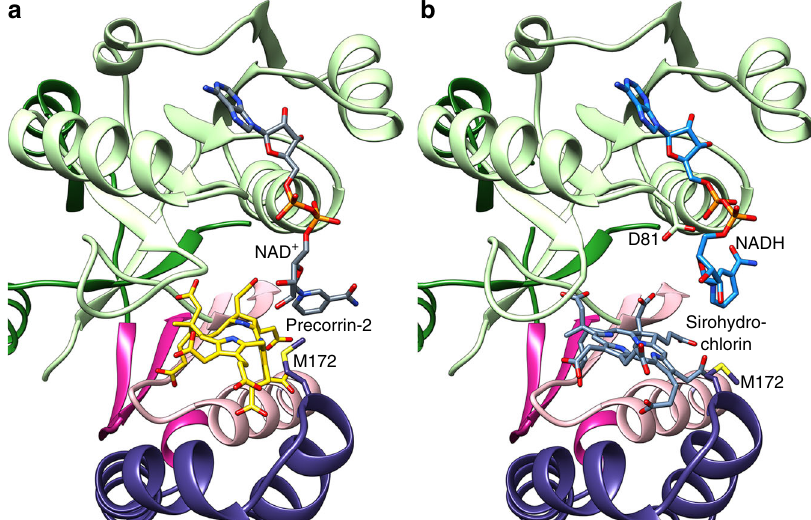
Fig. 5 Docking of NAD(H). a Computational docking of the NAD + (dark gray) to position the nicotinamide ring close to C15 in precorrin-2 (gold) required removing D81 ’ s side chain and reorienting M172, which take on positions that are antithetical to NAD + binding when the tetrapyrrole is present in the current crystal structure. The best binding pose for NAD + is shown after those changes were made, demonstrating how the phosphates must make close approach for the nicotinamide ring to position itself and suggesting that some small conformational changes involving D81 and M172 may occur in solution. b Including D81 and M172 pushes the nicotinamide ring of the NADH (blue) away from the more conjugated sirohydrochlorin (gray) in the docked structure, perhaps explaining how the reaction proceeds after